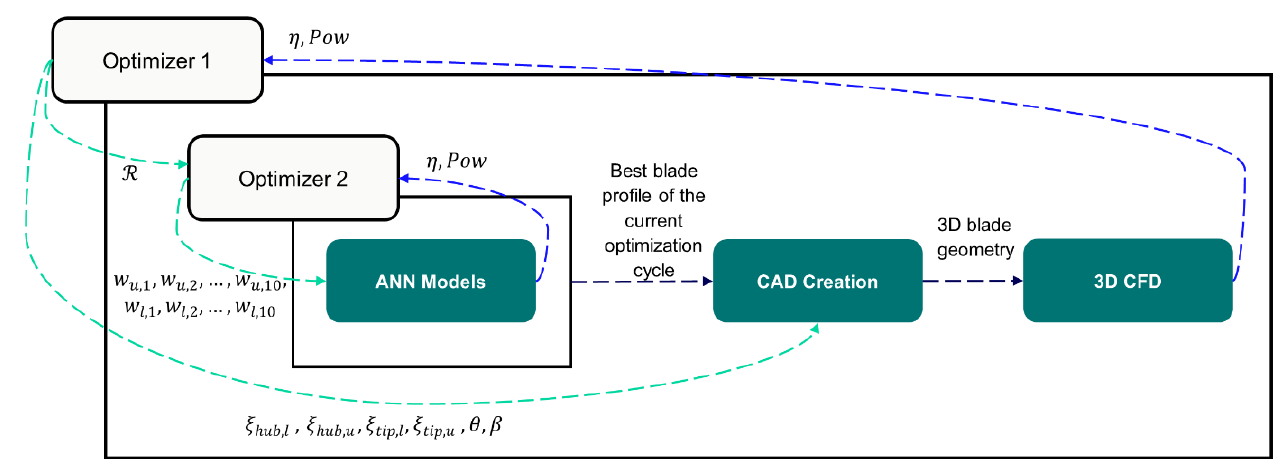
Figure 6. Optimization iteration hierarchy and data flow.